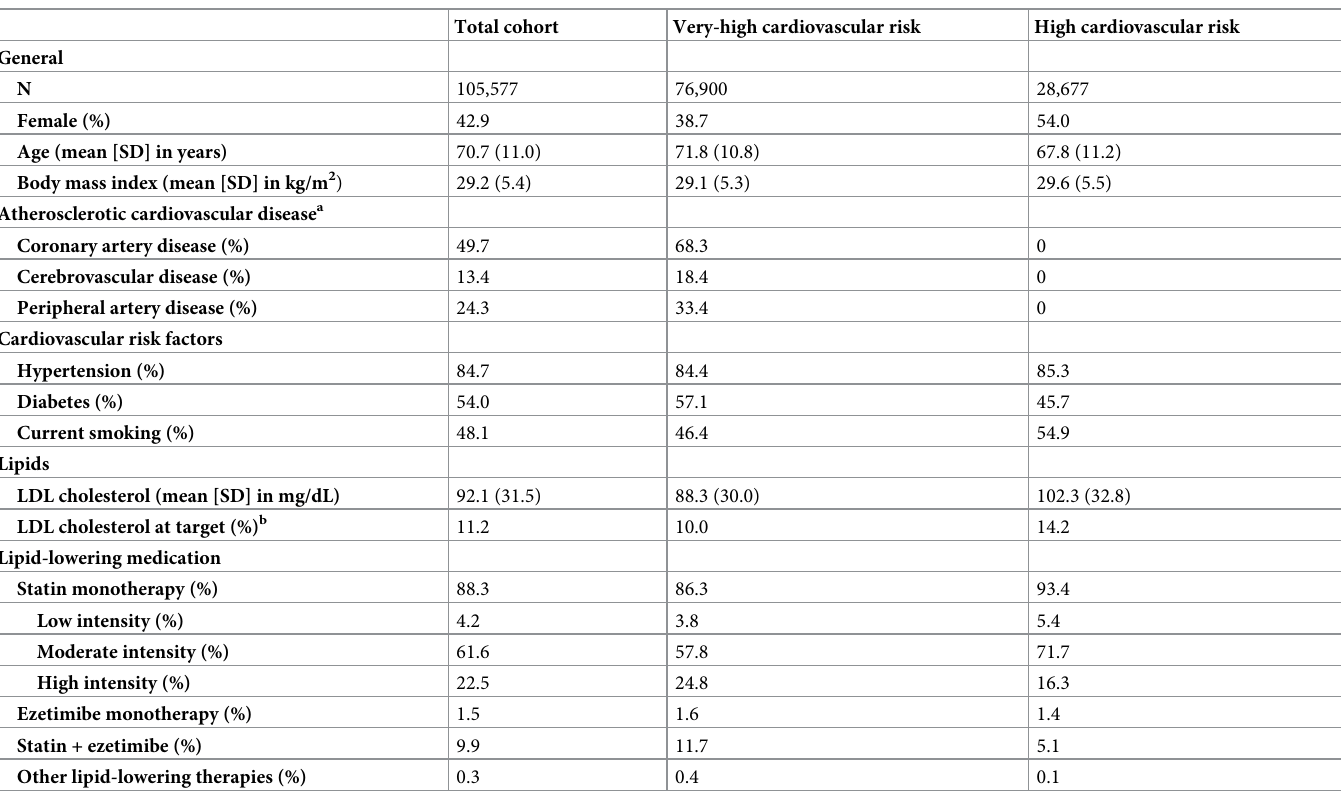
Table 1. Baseline